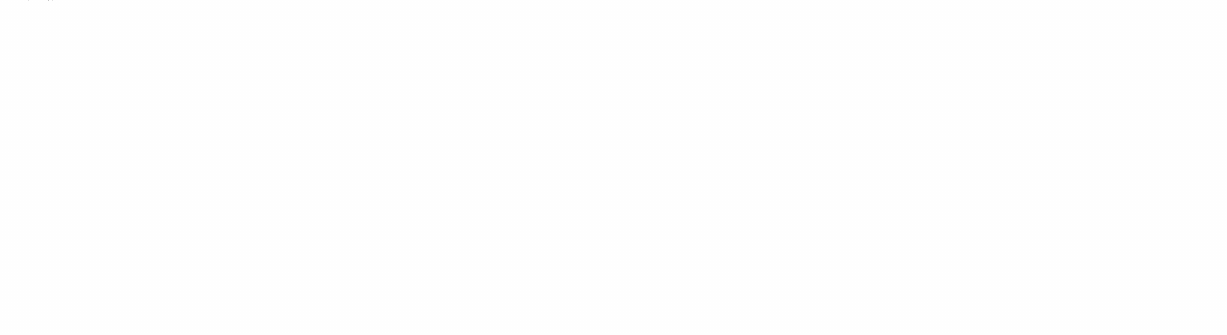
FIGURE 3 (a and b) Numbers of cells in the seeding compartment in simulations of the two-population model, with the parameters and initial conditions given in Table II, for the case of unsorted BM seeding without PBL. (a) Mixture seeding (1:1). The curves for the two populations coincide. (b) Sequential seeding, where syngeneic BM are seeded first. The upper curve represents syngeneic cells, and the lower allogeneic cells. It is evident that, although in this compartment both syngeneic and allogeneic cells have the same parameters, the population that is seeded first gains a significant advantage. (e and d) Numbers of cells in the proliferation compartment in simulations of mixture (c) and sequential (d) seeding. In both cases, the upper curve represents syngeneic cells and the lower curve represents allogeneic cells. Both populations approach steady-state values after 15